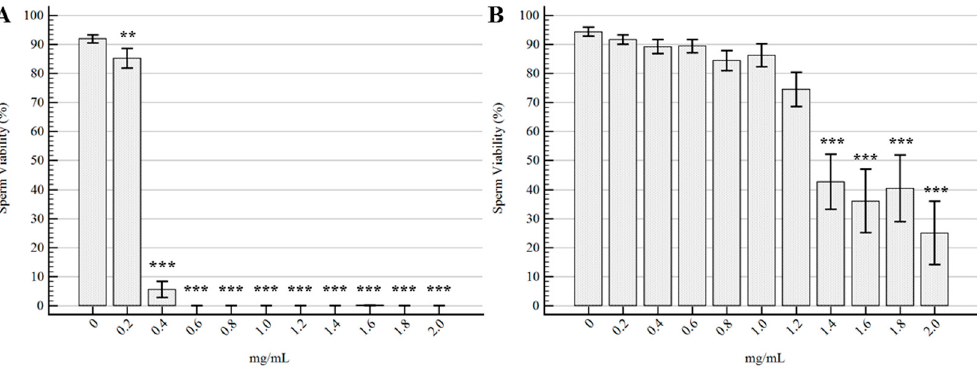
Figure 1. Effects of the EOs on sperm viability. ( A ) Thymbra capitata ; ( B ) Rosmarinus officinalis . Data are expressed as mean ± standard error of the mean ( n = 6). 0 mg/mL represents the control sample (only emulsifiers). ** = p < 0.01; *** = p < 0.001.